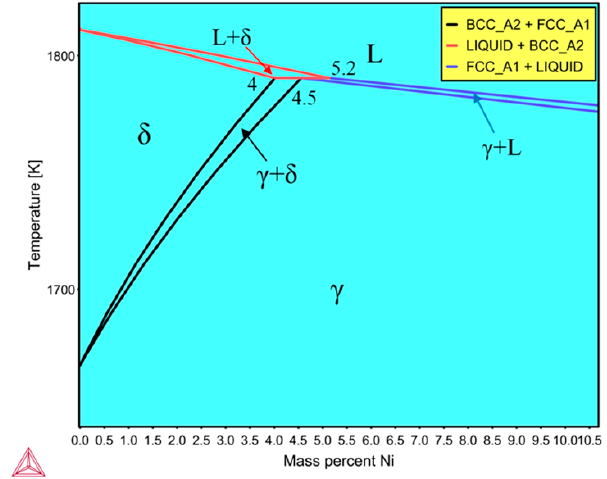
Figure 10. The schematic diagram of equilibrium distribution coefficient k .